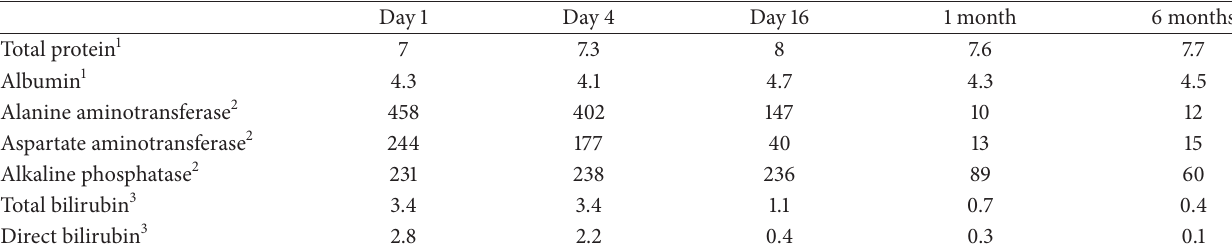
Table 1: Liver chemistries.